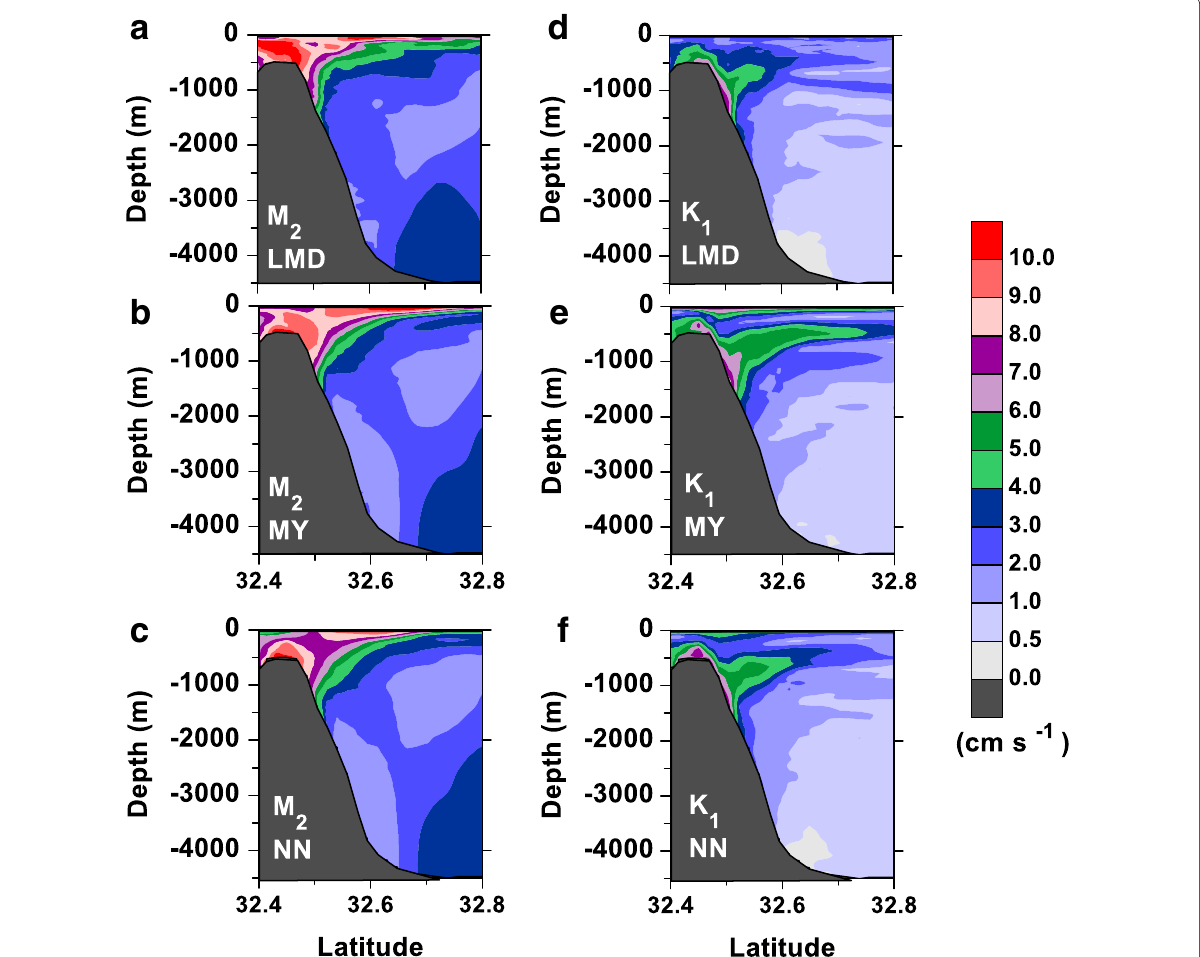
Fig. 4 The major axes of the a – c M 2 and d – f K 1 tidal ellipses for the baroclinic anomalies over the guyot from simulations using the a , d LMD, b , e MY, and c , f NN vertical mixing